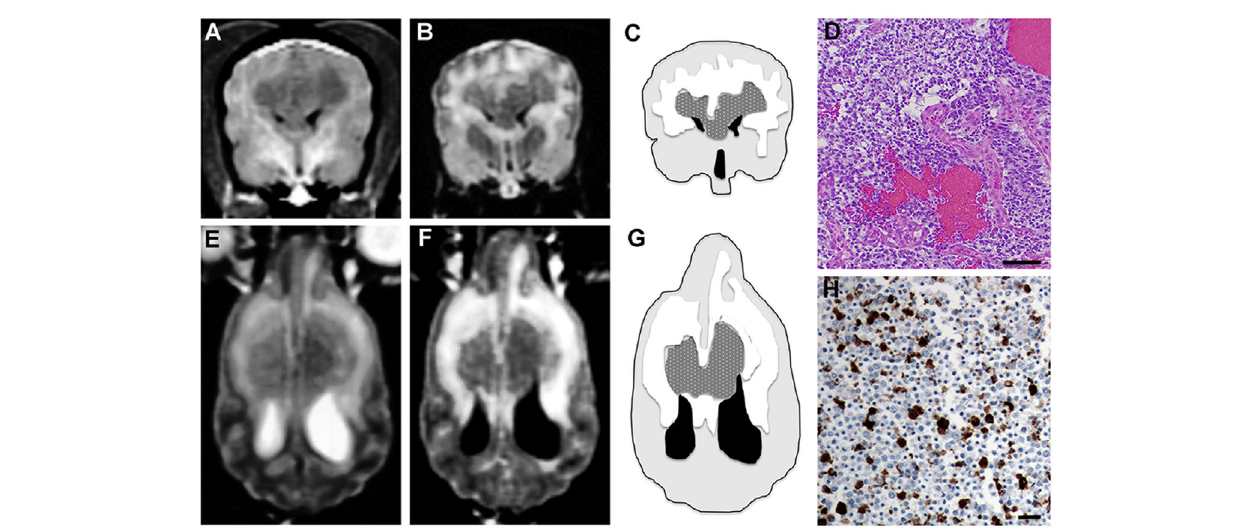
FIGURe 4 | symmetrical butterfly glioblastoma, Case 3 . Transverse T1 (a) and FLAIR (B) MR images at the level of the cruciate gyrus, demonstrating an intra-axial, bilaterally symmetric mass lesion present in the frontoparietal regions. Schematic, MR intensity-segmented transverse (C) and dorsal planar (G) representations of symmetrical bihemispheric appearance of butterfly GBM (stippled gray), perilesional edema (white), brain parenchyma (light gray), and ventricles (black). Histopathological features of GBM (D) include marked hypercellularity, cellular pleomorphism, and microvascular proliferation. Oligodendroglial components of the tumor are present throughout the section (H&E stain, bar = 200 μ m). In the dorsal planar PD-T2 (e) and FLAIR (F) images, the mass attenuates the rostral aspects of the lateral ventricles and is associated with extensive symmetrical perilesional hyperintensity within the surrounding white matter, consistent with edema. The mass demonstrates heterogeneous signal intensity in all sequences. (H) 50% of neoplastic astrocytes demonstrate intense GFAP staining, while neoplastic oligodendrocytes lack GFAP immunoreactivity (GFAP stain, horseradish peroxidase with 3,3 ′ -diaminobenzidine substrate, bar = 50 μ